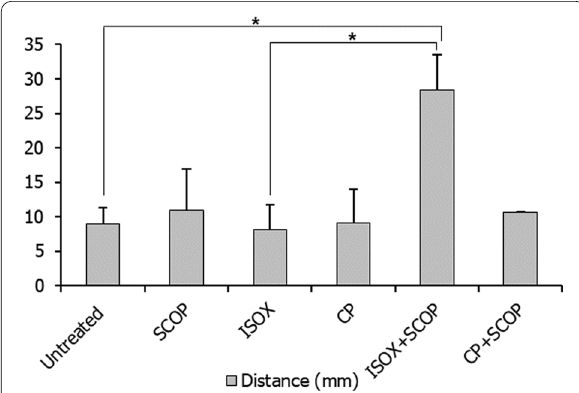
Fig. 9 Distance covered by the larvae treated by the test compounds. Histograms of the distances covered by untreated, scopolamine (SCOP)-treated, isoxazole (ISOX)-treated, Convolvulus pluricaulis (CP)-treated, ISOX SCOP-treated, and CP SCOP-treated + + larvae. Three independent experiments were conducted with each of the treatment conditions. *, **, and *** indicate p-value < 0.5, < 0.01 and < 0.001 of two-tailed unpaired t-test for untreated versus test groups (unless indicated otherwise)